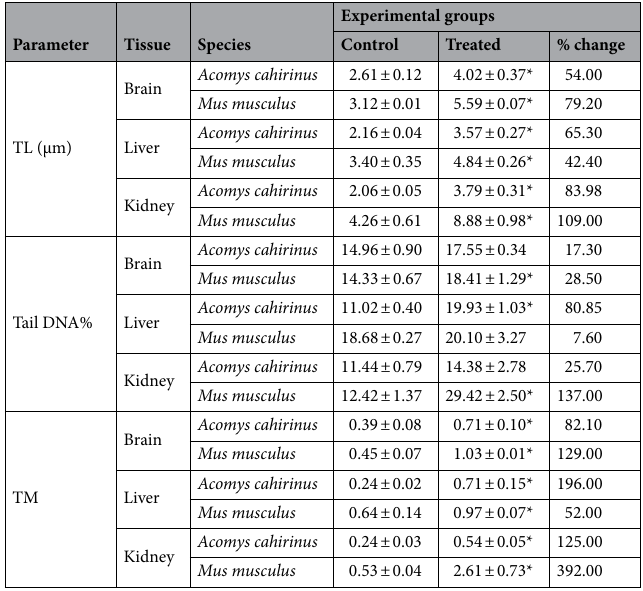
Table 2. Comet assay parameters analyzed in the brain, liver, and kidneys of Acomys cahirinus and Mus musculus following multiple doses (50 mg/kg for five consecutive days) of LA. Data displayed as mean ± standard error of mean. (*) represent significant (P < 0.05) differences as compared to the corresponding controls. TL tail length, TM tail